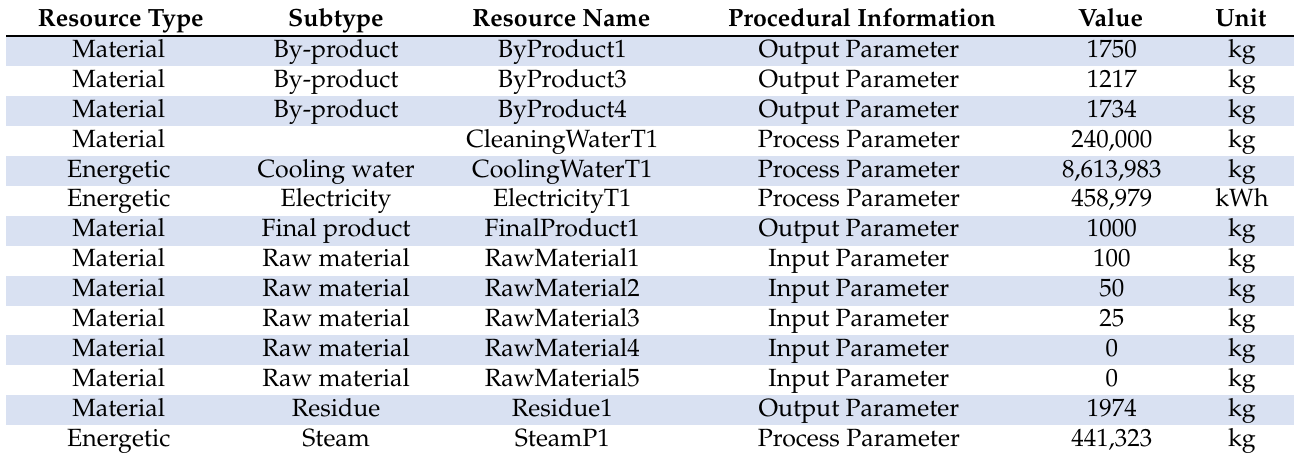
Table 6. The formula for the master recipe of acrylic fiber A production process